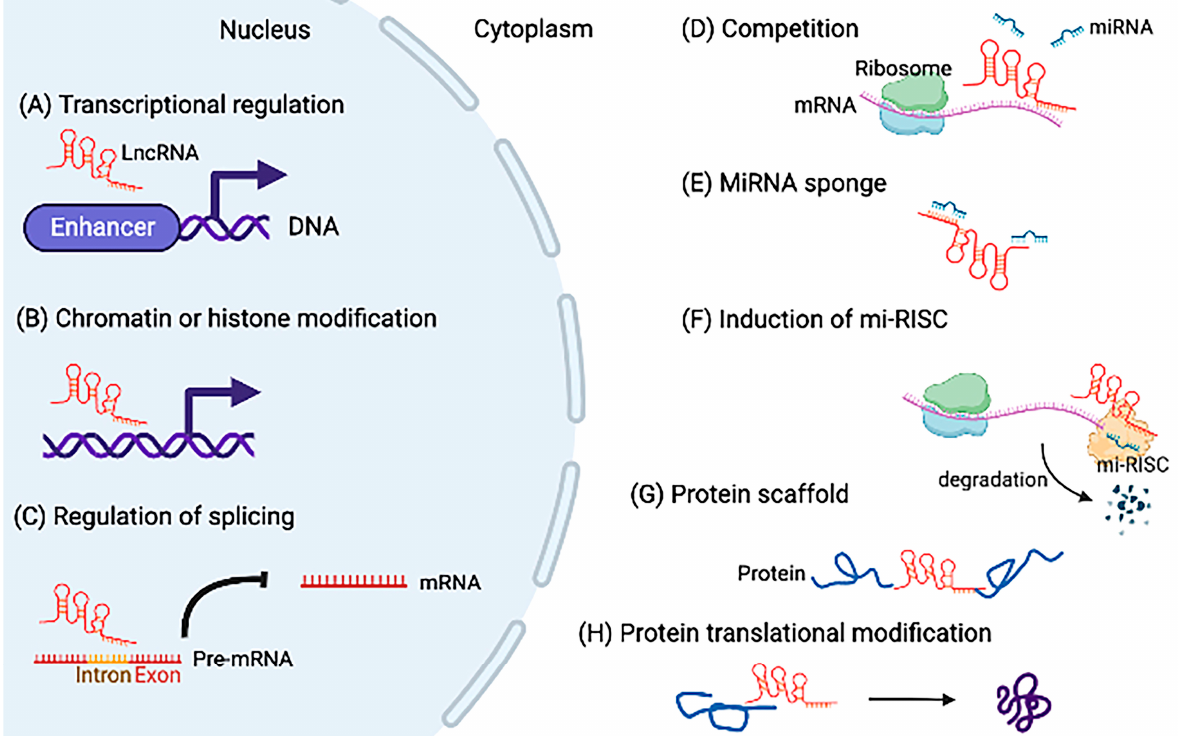
Figure 2. The mechanisms of long noncoding RNAs (lncRNAs)’ action in the nucleus and cytoplasm. In the nucleus: ( A ) LncRNAs act as enhancers and regulate transcription. ( B ) LncRNAs regulate chromatin or histone modi fi cation. ( C ) LncRNAs inhibit mRNA processing by the regulation of mRNA splicing. In the cytoplasm: ( D ) LncRNAs compete with miRNAs to bind mRNAs. ( E ) LncRNAs act as miRNA sponges. ( F ) LncRNAs promote the miRNA-induced silencing complex (mi-RISC) to regulate mRNA transcription. ( G ) LncRNAs act as sca ff olds to modify transcriptional complexes. ( H ) LncRNAs bind to speci fi c proteins to regulate pos tt ranslational modi fi cation.